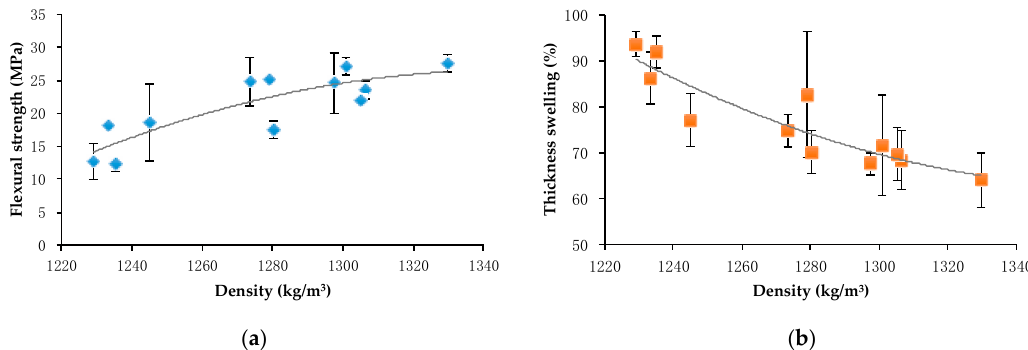
Figure 3. ( a ) Flexural strength and ( b ) thickness swelling as functions of panel density for the fiberboards produced from extrusion refined straw with varying L/S ratios and press cake addition.